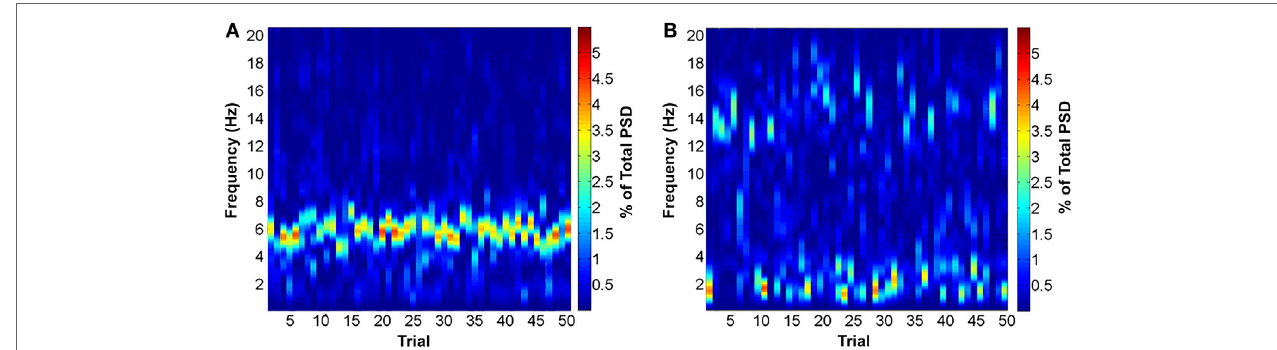
FiGURe 1 | Surface plots of power spectral density (PSD) of the pre-CS period triggering a trial for 1 day of training for an animal in the T + (A) and T − condition (B) . Trials in the T + condition were consistently triggered under conditions of high theta and low delta and alpha. The T − condition was triggered by periods of low theta and high delta or alpha. Note that the T − condition is more heterogeneous than T + , with trials being triggered under both high delta and high alpha conditions. Figures created from data published in Cicchese et al.